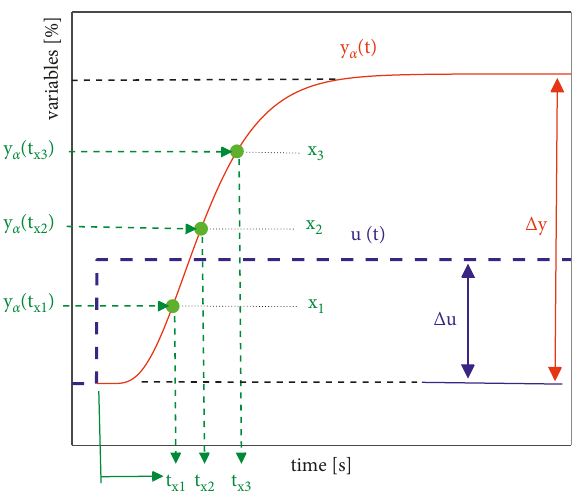
Figure 3: Step-input signal and arbitrary representative points on the process reaction